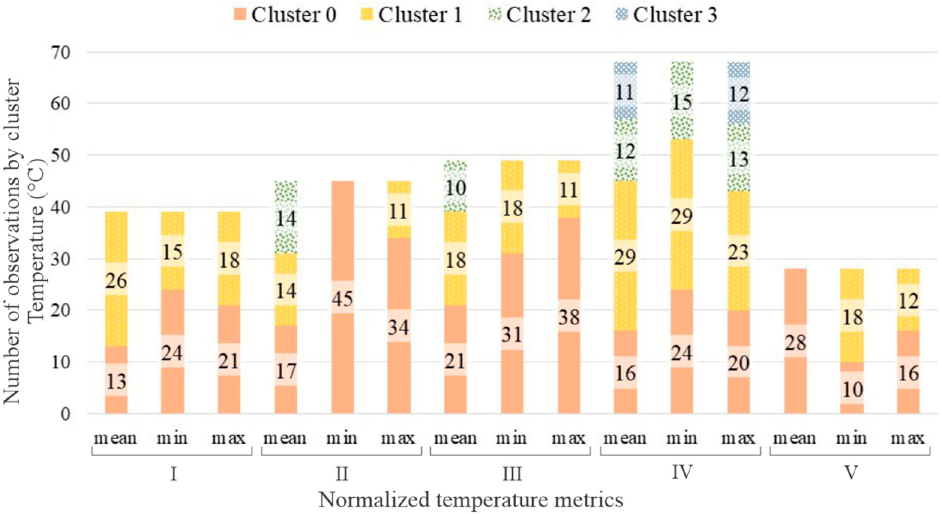
Figure 4. Stacked bars graph presenting the number of elements by cluster and temperature metric for each subject.